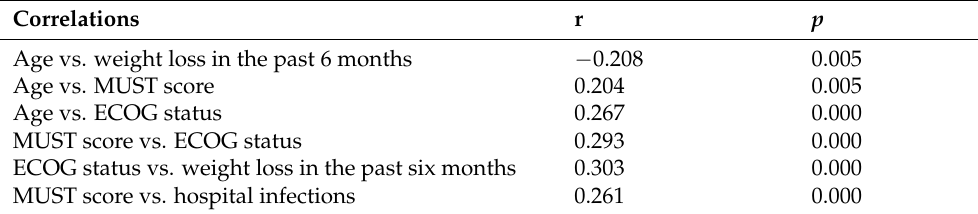
Table 3. Presentation of the correlations of factors related to nutrition and performance